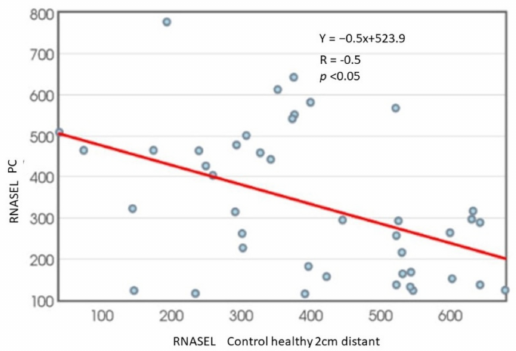
Figure 6. RNASEL correlation between values in PC and corresponding control specimens of healthy